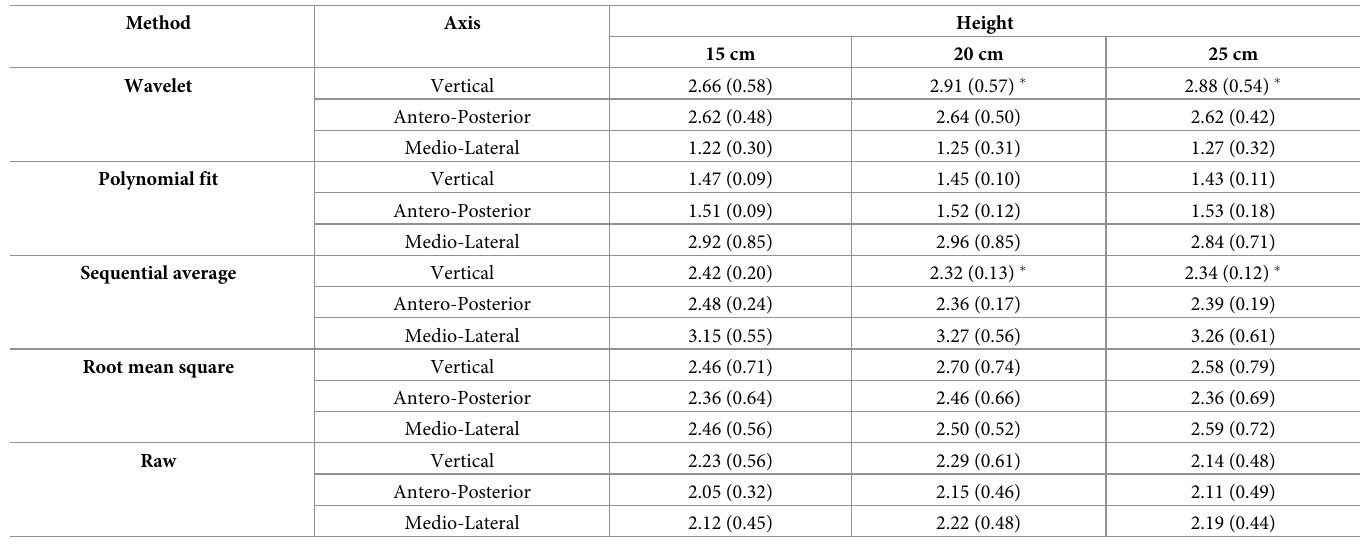
Table 1. Pairwise comparisons between drop jumps heights.